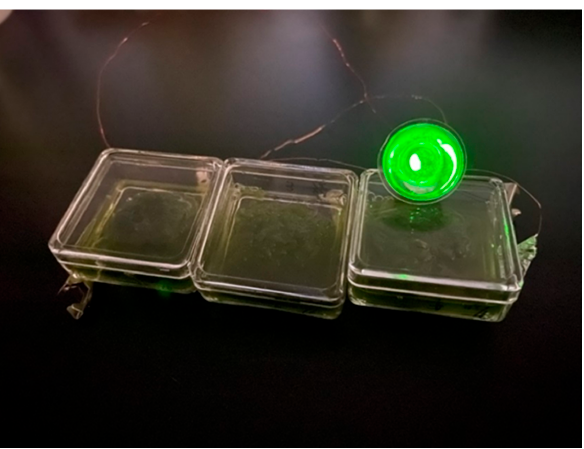
Figure 10. Photograph of the driving of the green LED lamp using the fuel cell based on the chitin electrolyte and the hydrogen fuel of the PSII–chitin composite.